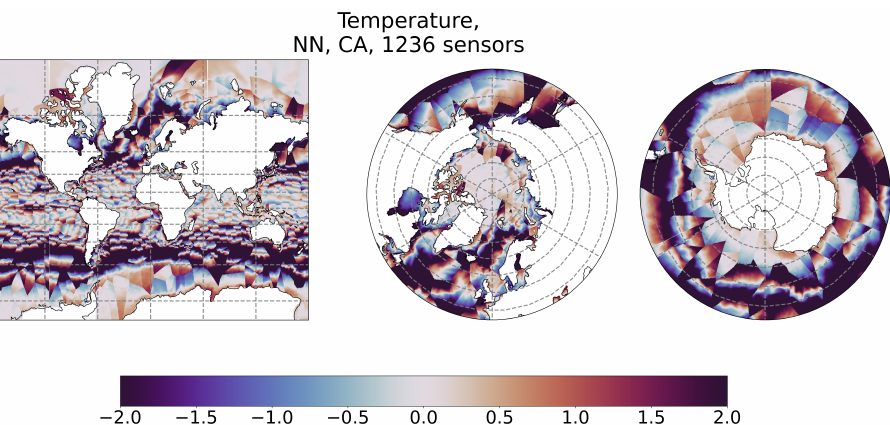
Figure A6. Spatial distribution of reconstruction bias by the Nearest Neighbor (NN) method from 1236 measurements with placement using the Concrete Autoencoder (CA).